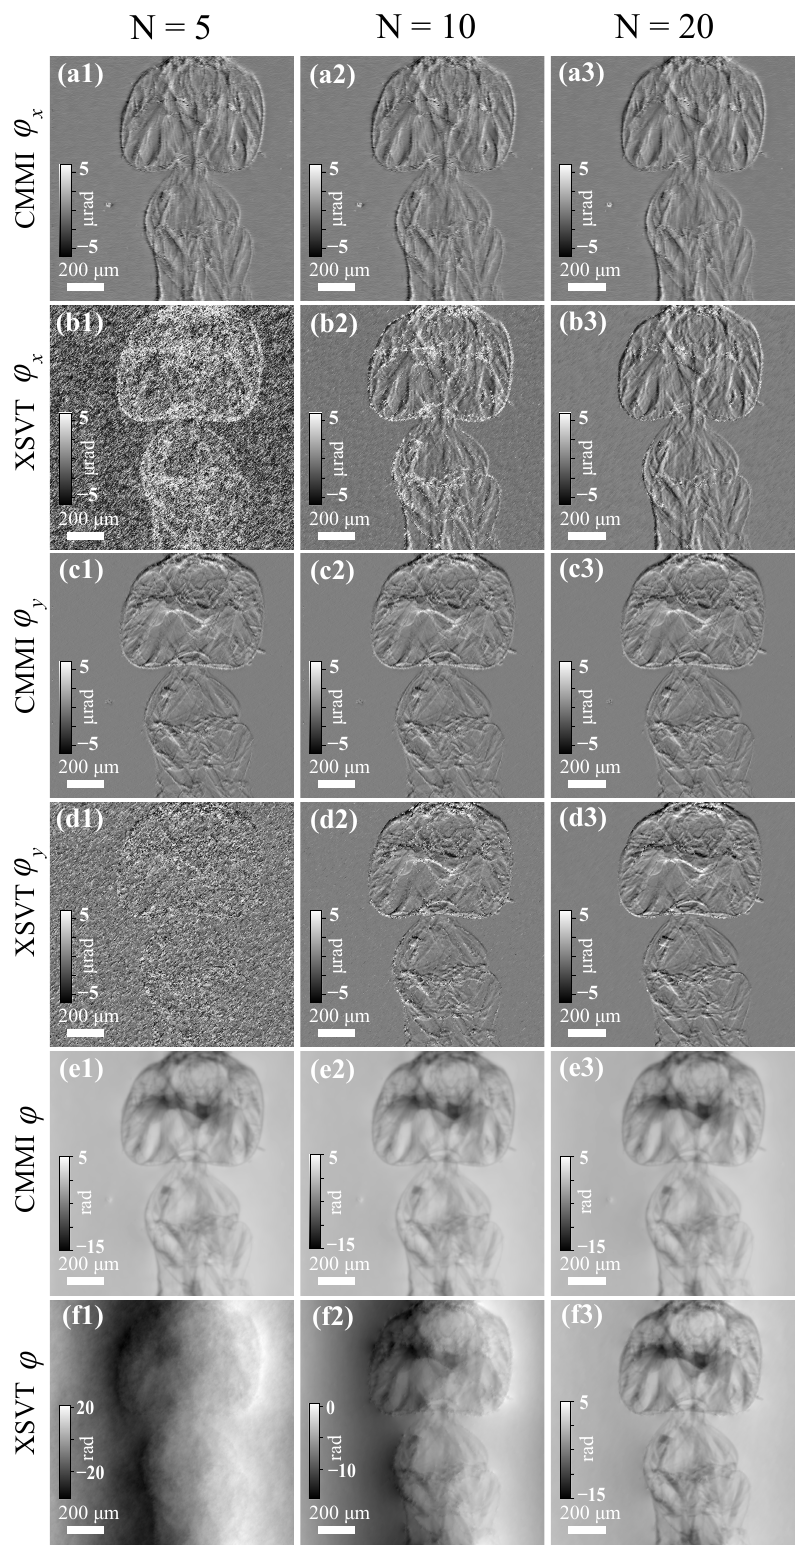
Figure 3. Comparison of scanning CMMI and XSVT results with different numbers of scanning positions ( N = 5, 10, and 20, for the left, middle, and right columns, respectively). Reconstructed. ( a1 – a3 ) and ( b1 – b3 ) horizontal differential phase, ( c1 – c3 ) and ( d1 – d3 ) vertical differential phase, and ( e1 – e3 ) and ( f1 – f3 ) phase images using scanning CMMI and XSVT,